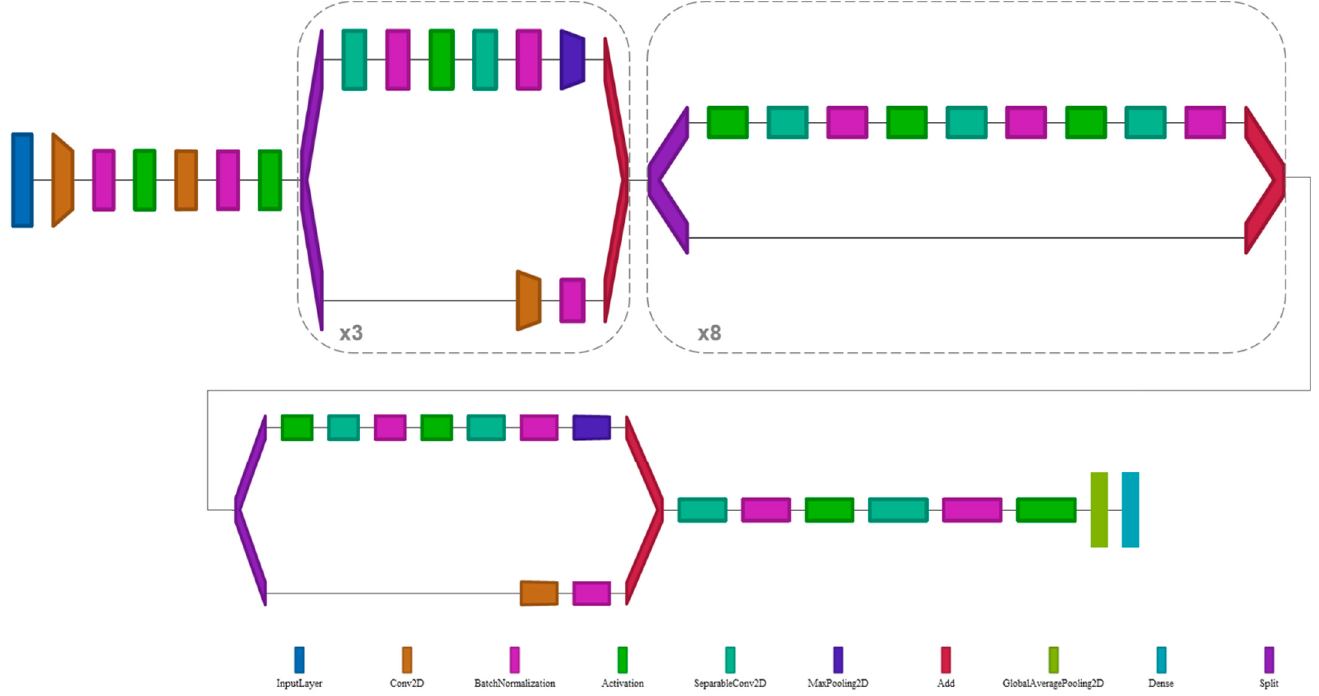
Figure 2. Schematic diagram of deep learning architecture based on the Xception